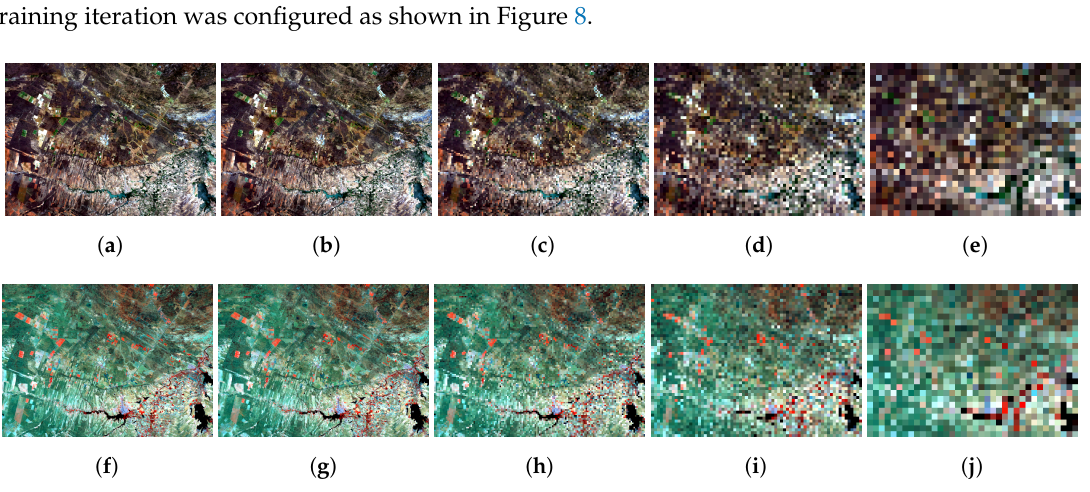
Figure 8. Landsat test set input for the ratios of 2 ( a , f ), 4 ( b , g ), 8 ( c , h ), 16 ( d , i ) and 32 ( e , j ), with resolutions of 581 × 419, 290 × 209, 145 × 104, 72 × 52, and 36 × 26